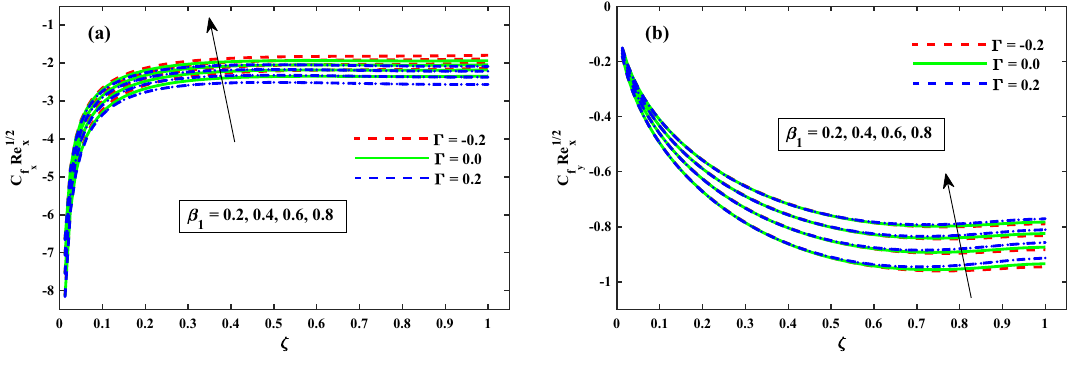
1 / 2 x in x-direction, and Cf y Re